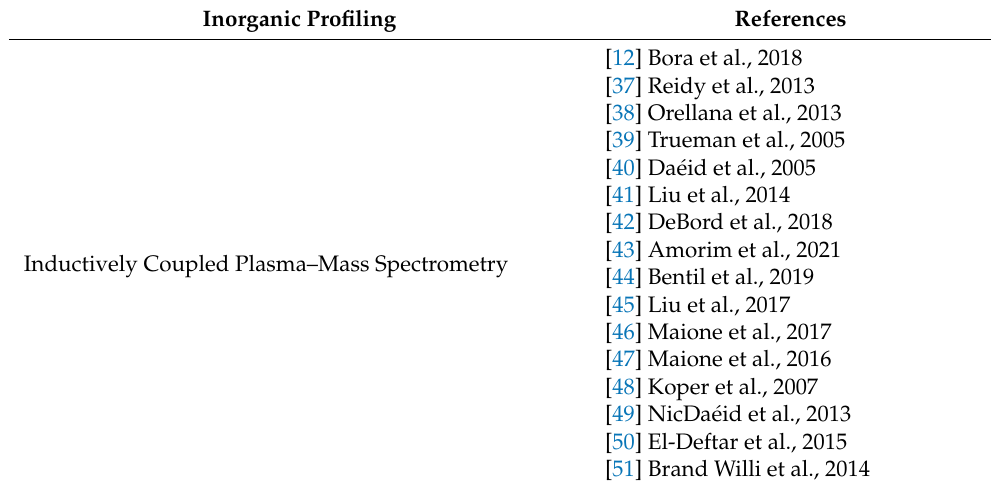
Table 3. Inorganic profiling through Inductively Coupled Plasma–Mass Spectrometry of illicit drugs. Inorganic